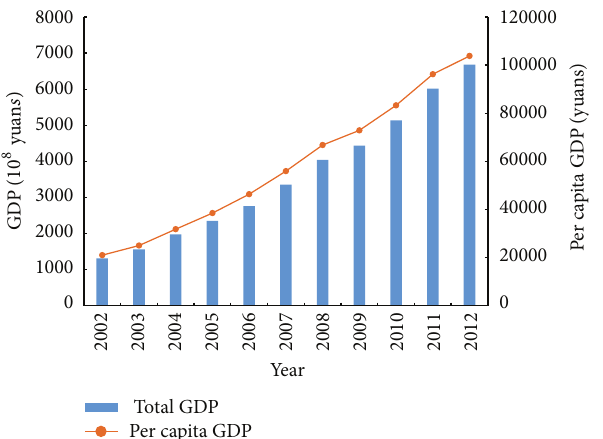
Figure2:ThetotalGDPandpercapitaGDPintheNansiLakeBasin during 2002 ∼ 2012.